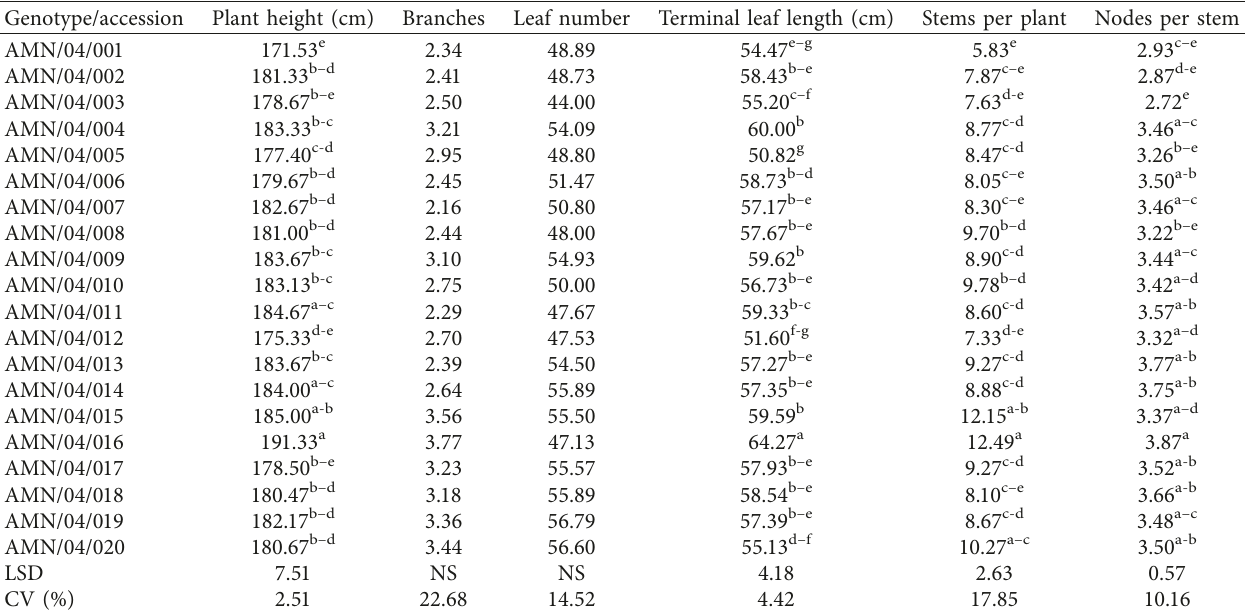
Table 3: Mean performance of genotypes of Bambara groundnut for growth